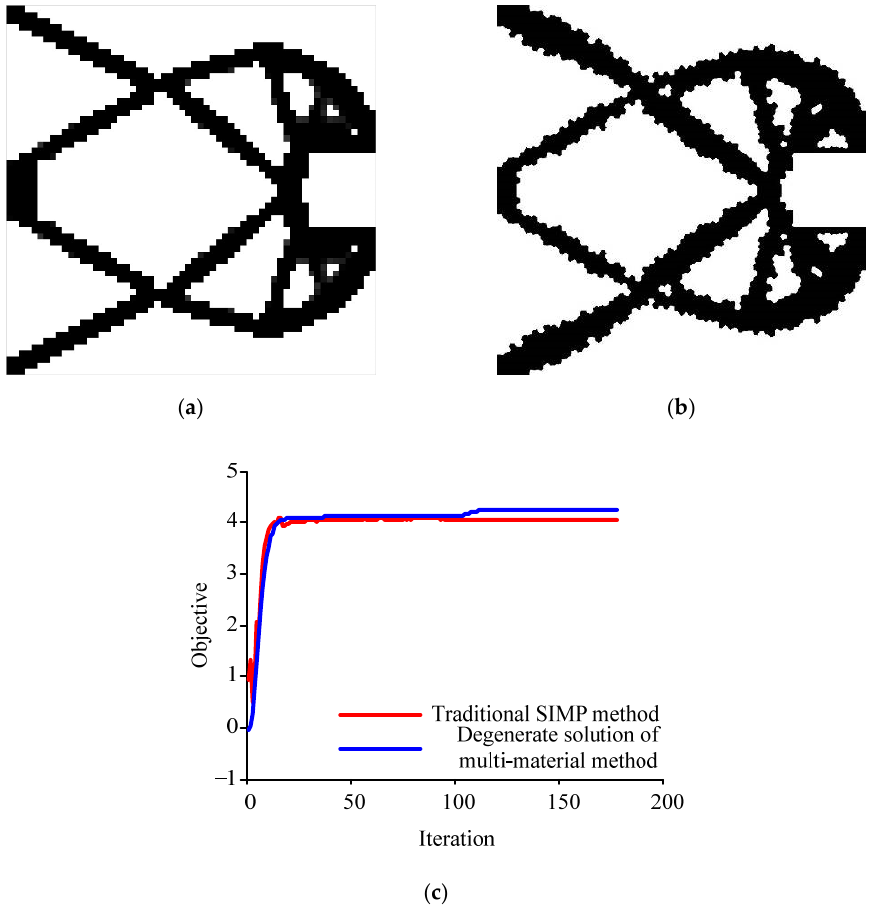
Figure 10. Optimization results: ( a ) Traditional SIMP method topologies; ( b ) degenerate solution of multi-material method (case 1); ( c ) convergence plot. Table 4. Maximum displacement at the output port of compliant gripper.